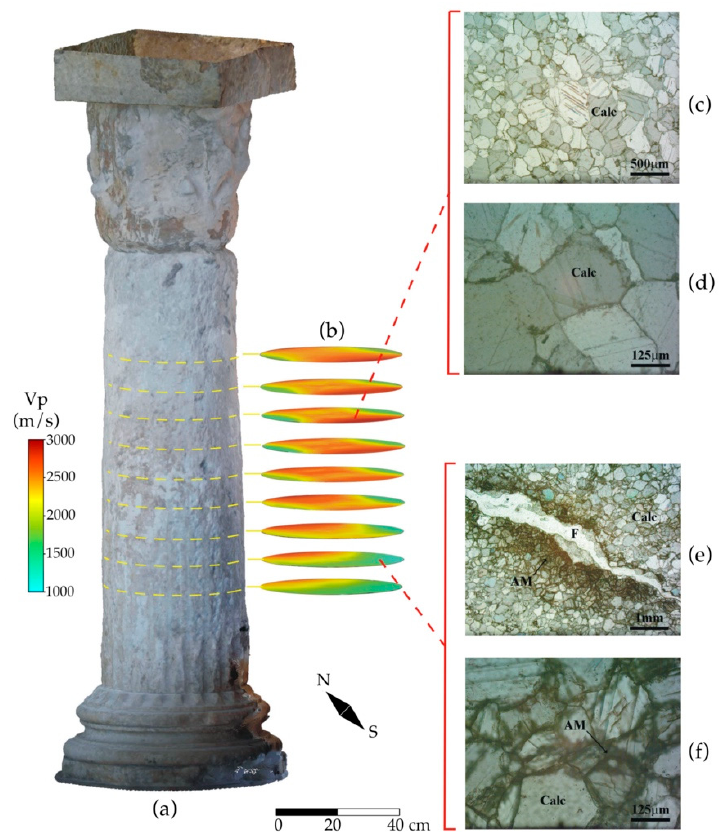
Figure 9. Integrated analysis of the ultrasonic tomography and thin sections. ( a ) CRP model; ( b ) tomographic slices; ( c , d ) thin sections of the marble in a sound sector of the studied column; ( e , f ) thin sections of the marble in a degraded sector of the studied column. Calc (calcite); F (fracture); AM (altered material).